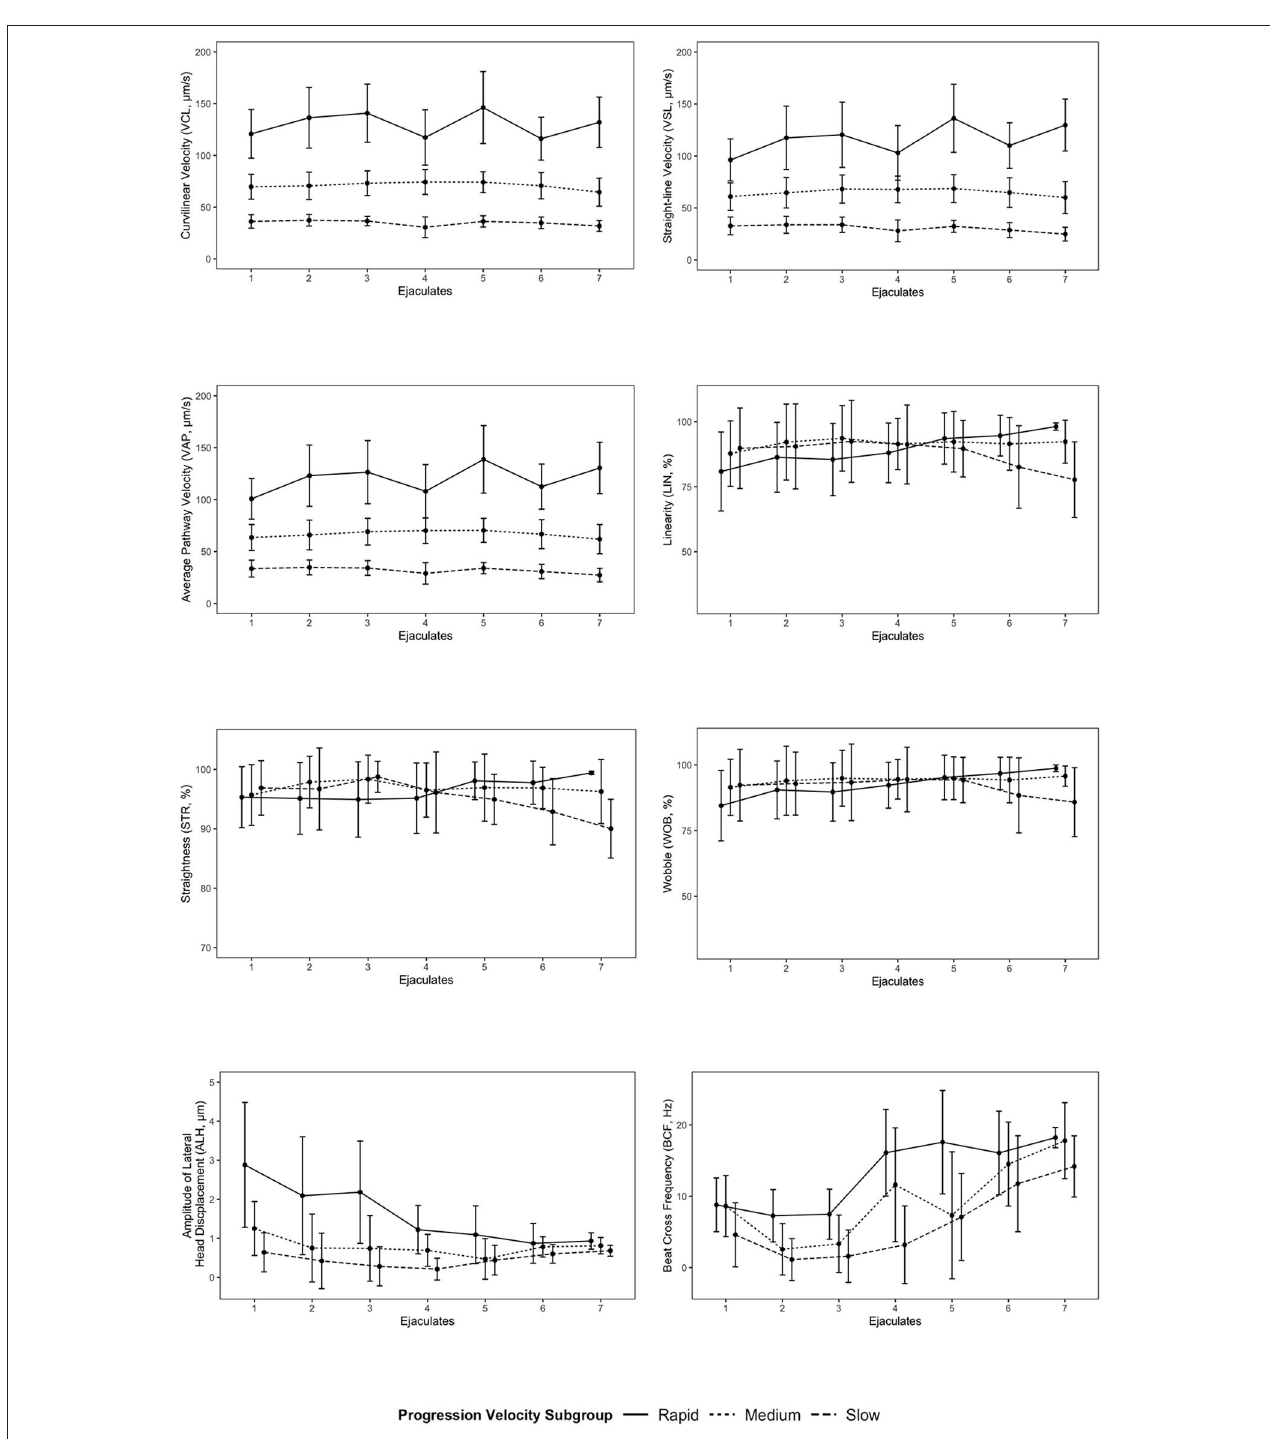
FIGURE 4 | Mean values of progression velocity subgroups for each kinematic parameter for each individual ejaculate sample. Error bars represent standard deviation. Points for progression velocity subgroups for each ejaculate sample are offset for linearity (LIN), straightness (STR), wobble (WOB), amplitude of lateral head displacement (ALH), and beat cross frequency (BCF) to provide visual clarity between each subgroup. membrane integrity and morphology). It should be noted that While some parameters were considered very good (motility, plasma membrane integrity may be artificially low based on acrosome integrity, chromatin condensation, and chromatin the eosin-nigrosin method that was utilized in this study. maturation), other parameters were moderate to poor (plasma